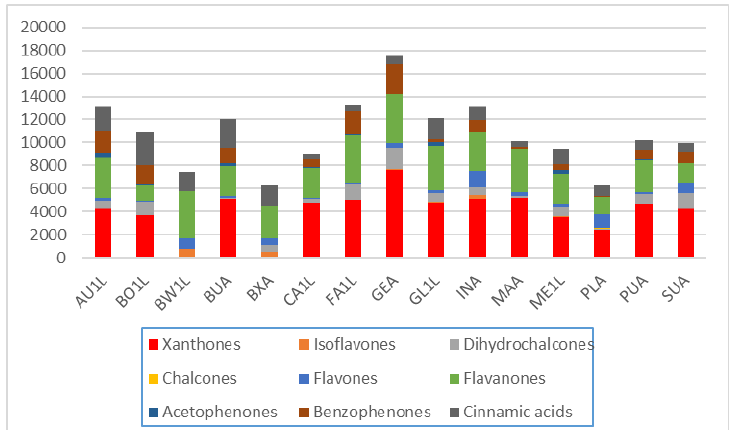
Figure 10. Average levels (mg / kg relative to mangiferin) of nine classes of phenolic compounds in leaf samples of 15 species of Cyclopia . The A at the end of the species codes means that it is an average value for all the leaf samples of that species analysed–see Table 2). C. aurescens (AU), C. bolusii (BO), C. bowiena (BW), C. burtonii (BU), C. buxifolia (BX), C. capensis (CA), C. falcata (FA), C. genistoides (GE), C. glabra (GL), C. intermedia (IN), C. maculata (MA), C. meyeriana (ME), C. plicata (PL), C. pubescens (PU) and C. subternata